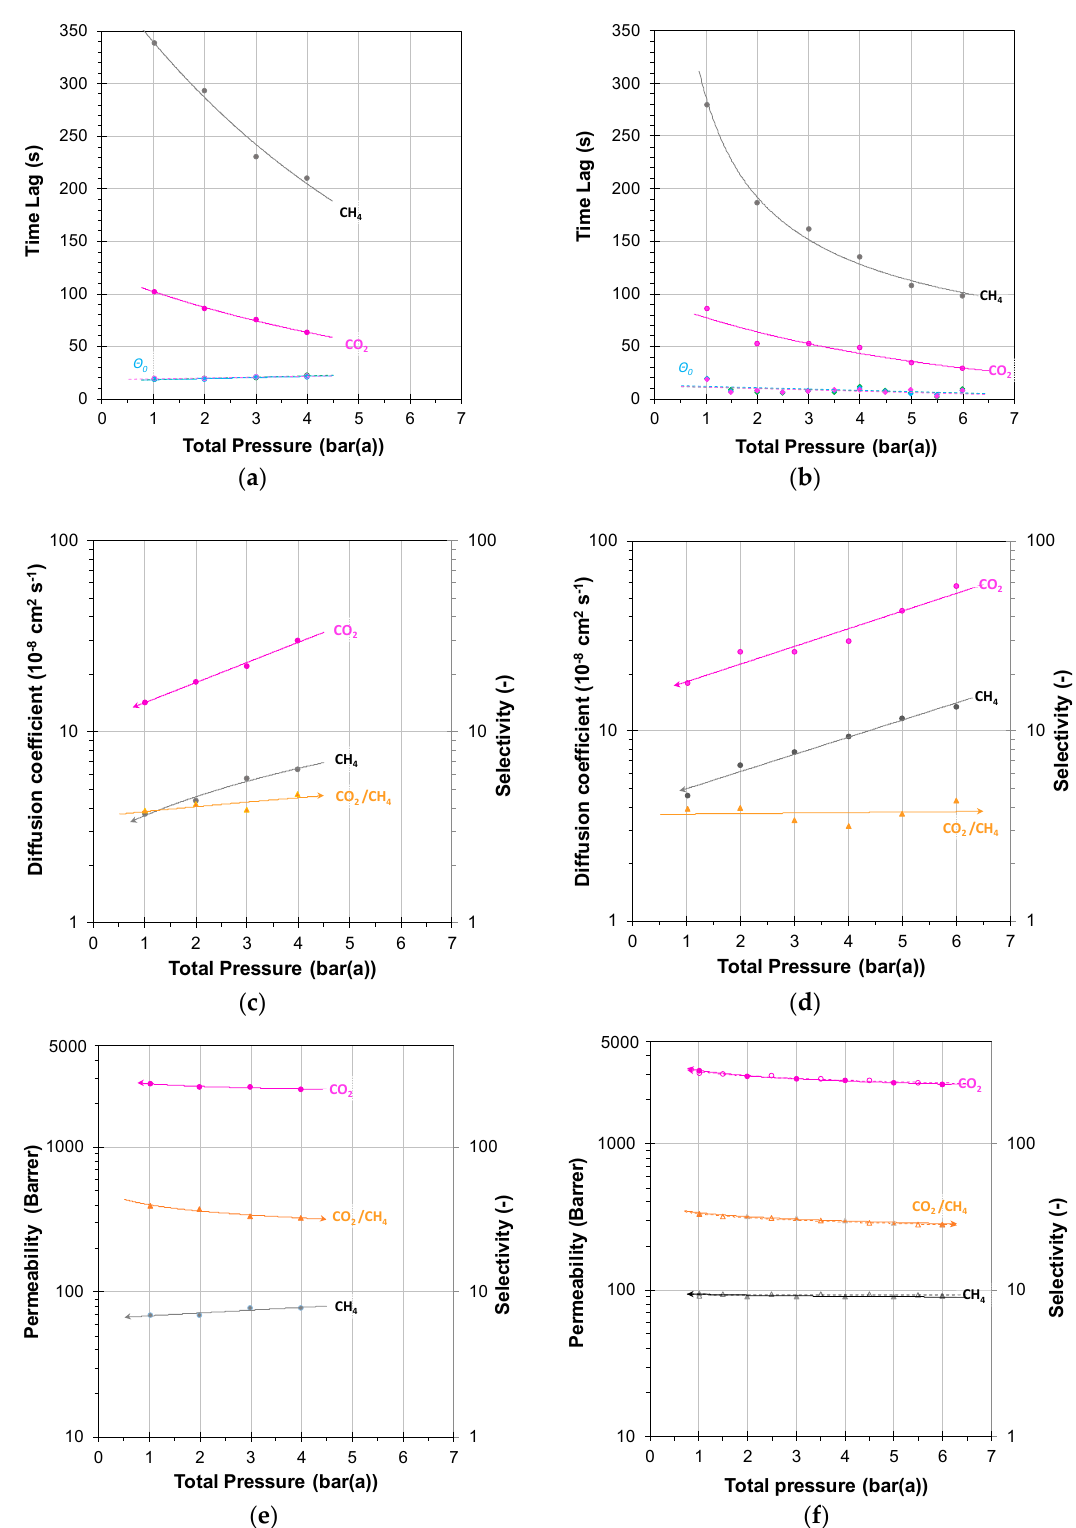
Figure 5. Individual time lag for CO 2 and CH 4 in a 2088 days aged sample of PIM-SBF-1 with individual pressure steps ( a ) and a stepwise incremental pressure increase ( b ). The instrumental time lag at the bottom of the graphs ( a , b ) needs to be subtracted for the calculation of the corresponding diffusion coefficients ( c , d ), showing strong pressure dependence. The permeability and selectivity show a much lower pressure dependence ( e , f ). Gas mixture 35/65 vol % CO 2 /CH 4 .